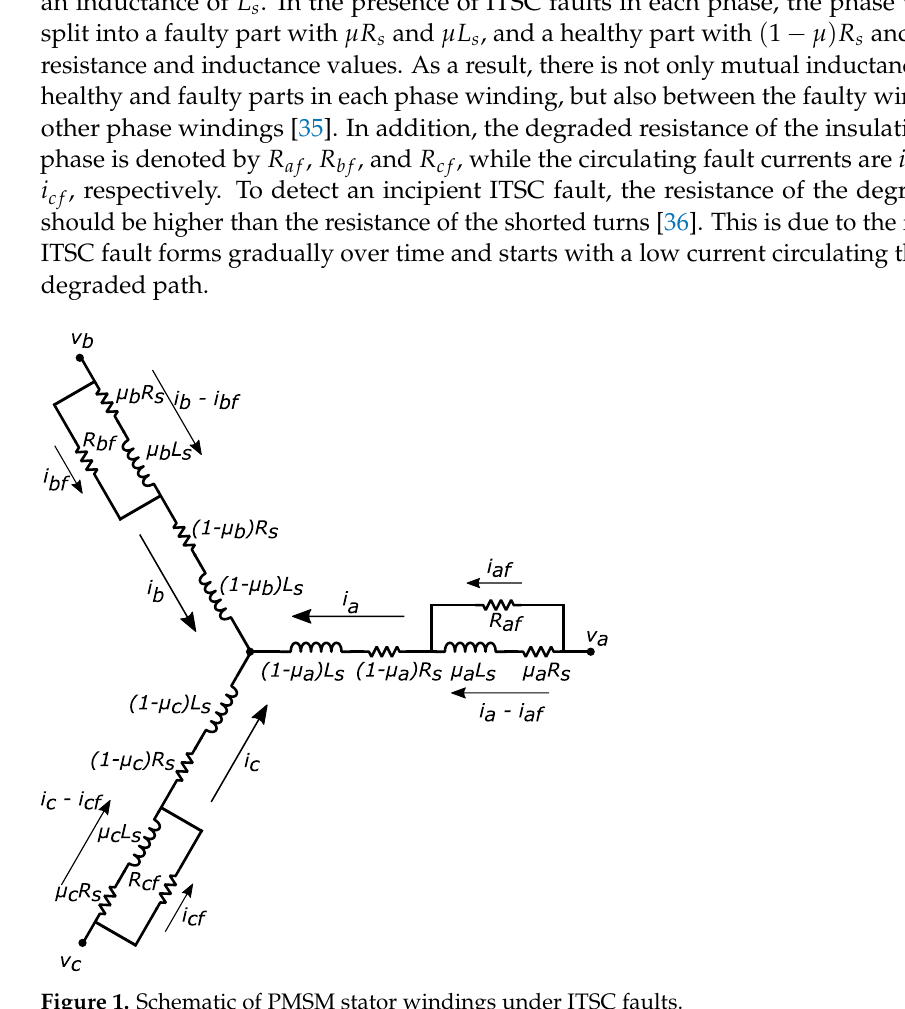
Figure 1. Schematic of PMSM stator windings under ITSC